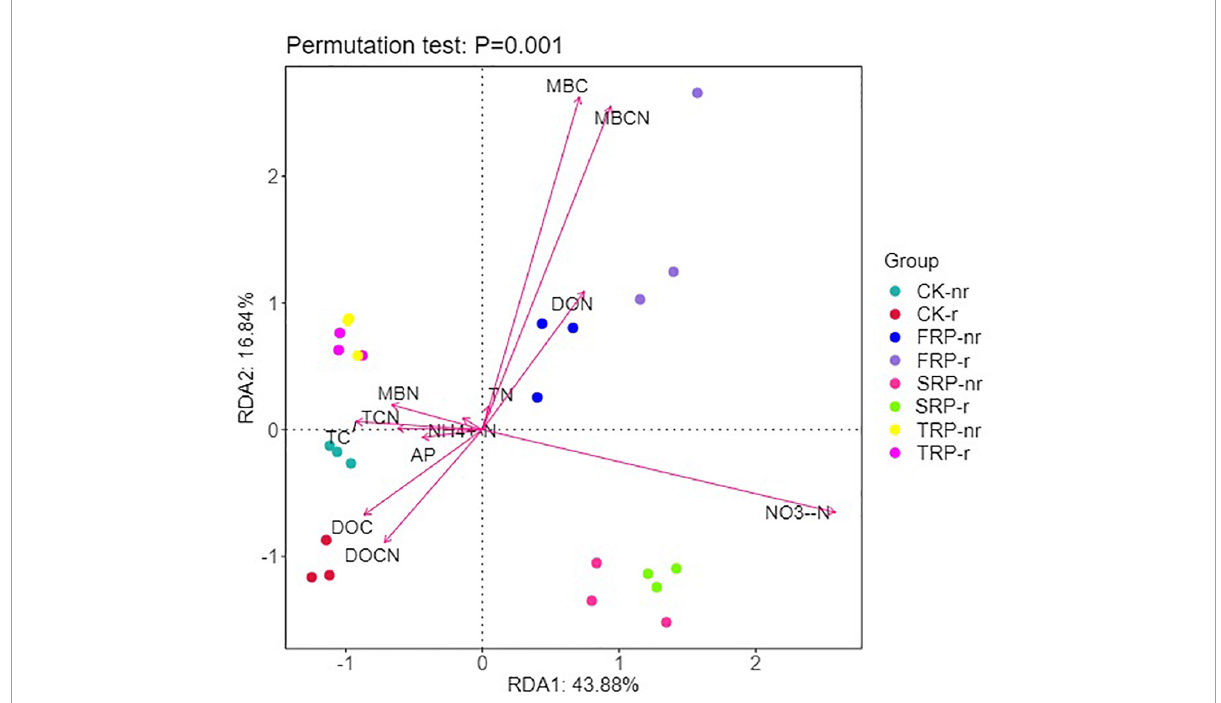
FIGURE9 Redundancy analysis (RDA) explains the impact of environmental variables (arrows) on the structure of fungal community in different seedings and soil types (using rhizosphere soil and bulk soil data). The values for axis 1 and axis 2 are the percentages explained for the correspondent axes. Data were obtained from different successive planting generations and soil types (CK, Nanmu seedings; FCP, first-generation seedings; SCP, second-generation seedings; TCP, third-generation seedings; r, rhizosphere soil; nr, bulk